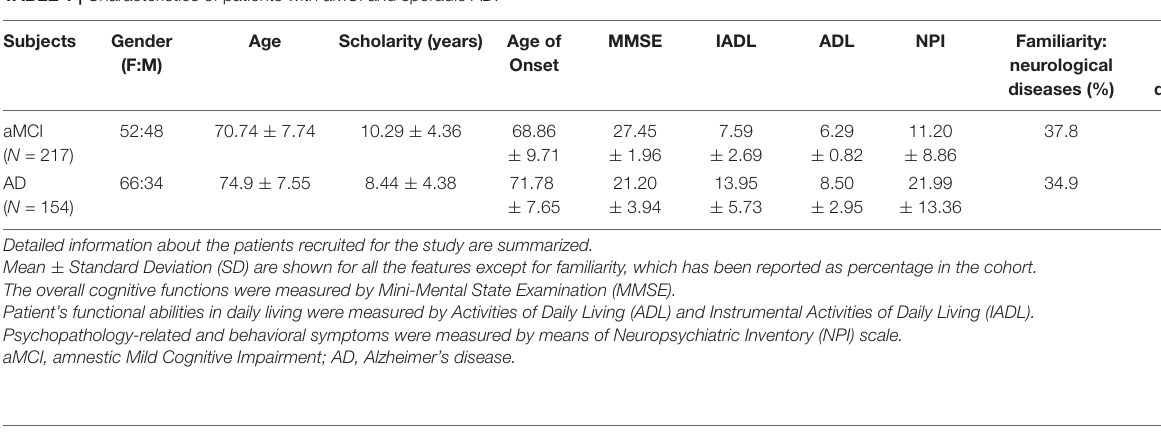
Frontiers in Aging Neuroscience |